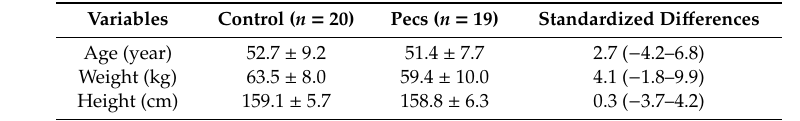
Table 1. Patients’ characteristics.